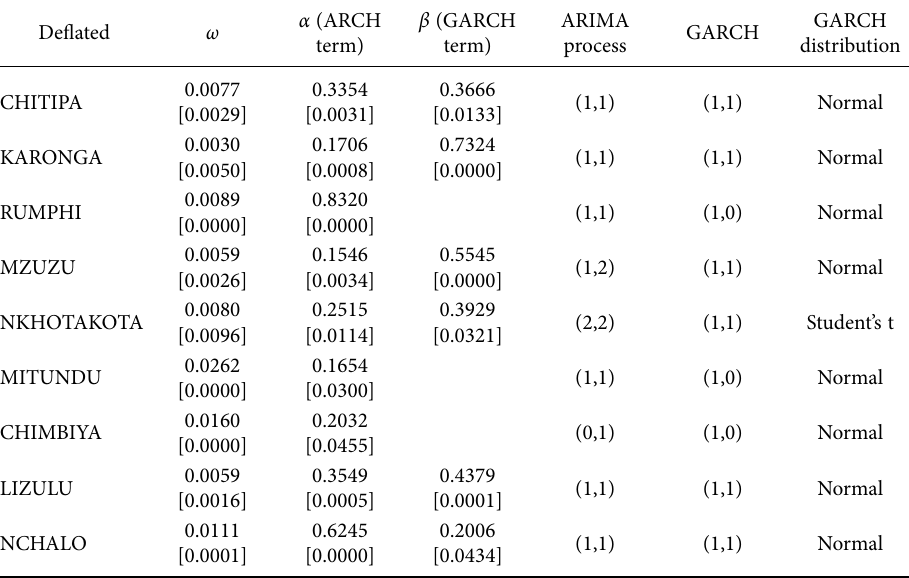
Table 4. GARCH estimate of maize price volatility in Malawian local-economy markets (January 1991-March 2013).